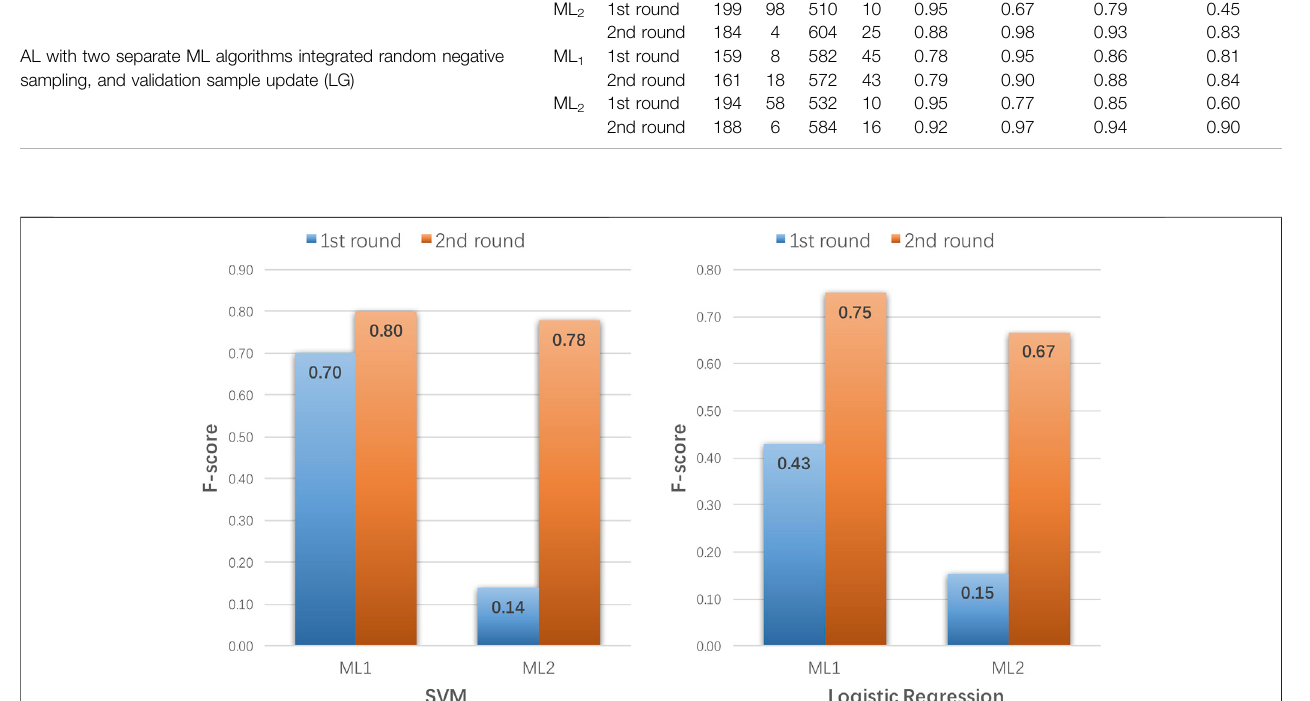
FIGURE 7 | Performance of ML 1 and ML 2 on uncertainty samples with SVM and logistic regression as the machine learning (ML) methods.